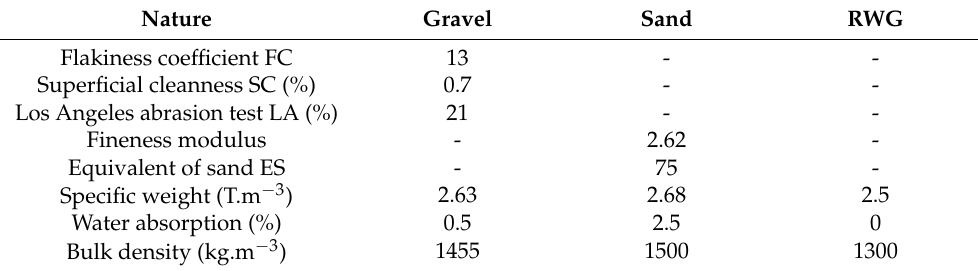
Table 2. Physical properties of different used aggregates.